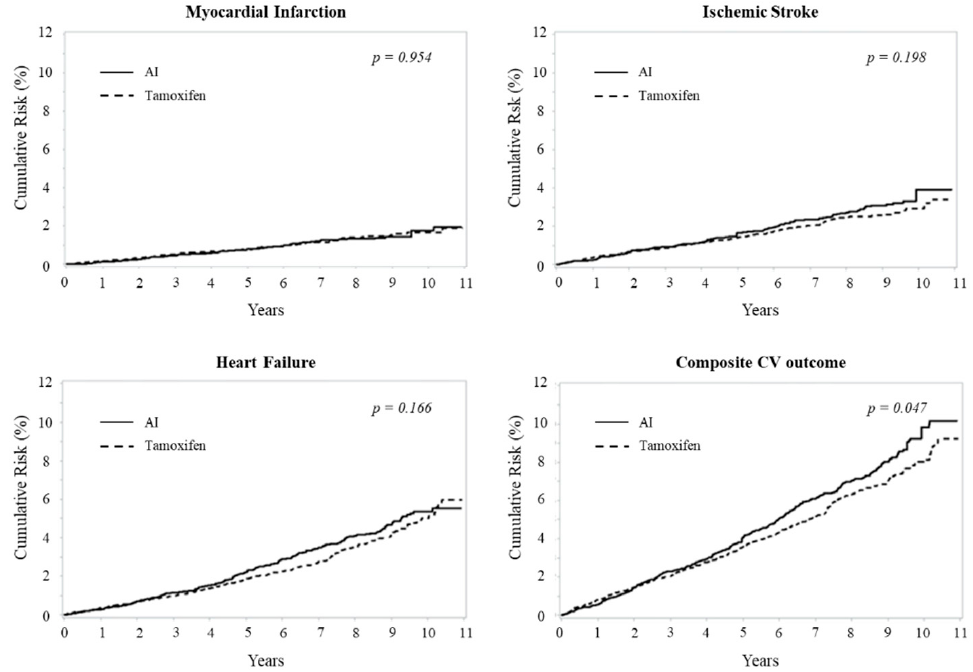
Figure 2. Kaplan–Meier estimates of the cumulative risk in patients with breast cancer treated, re- spectively, with aromatase inhibitors (AI) and tamoxifen. Cumulative risk over an 11-year horizon of any cardiovascular outcome ( top left ), myocardial infarction ( top right ), ischemic stroke ( bottom left ) and heart failure ( bottom right ) based on an intention-to-treat approach in which cohort women were classified on the therapy (aromatase inhibitors or tamoxifen) initially received. Patients were 1:1 matched by propensity score.